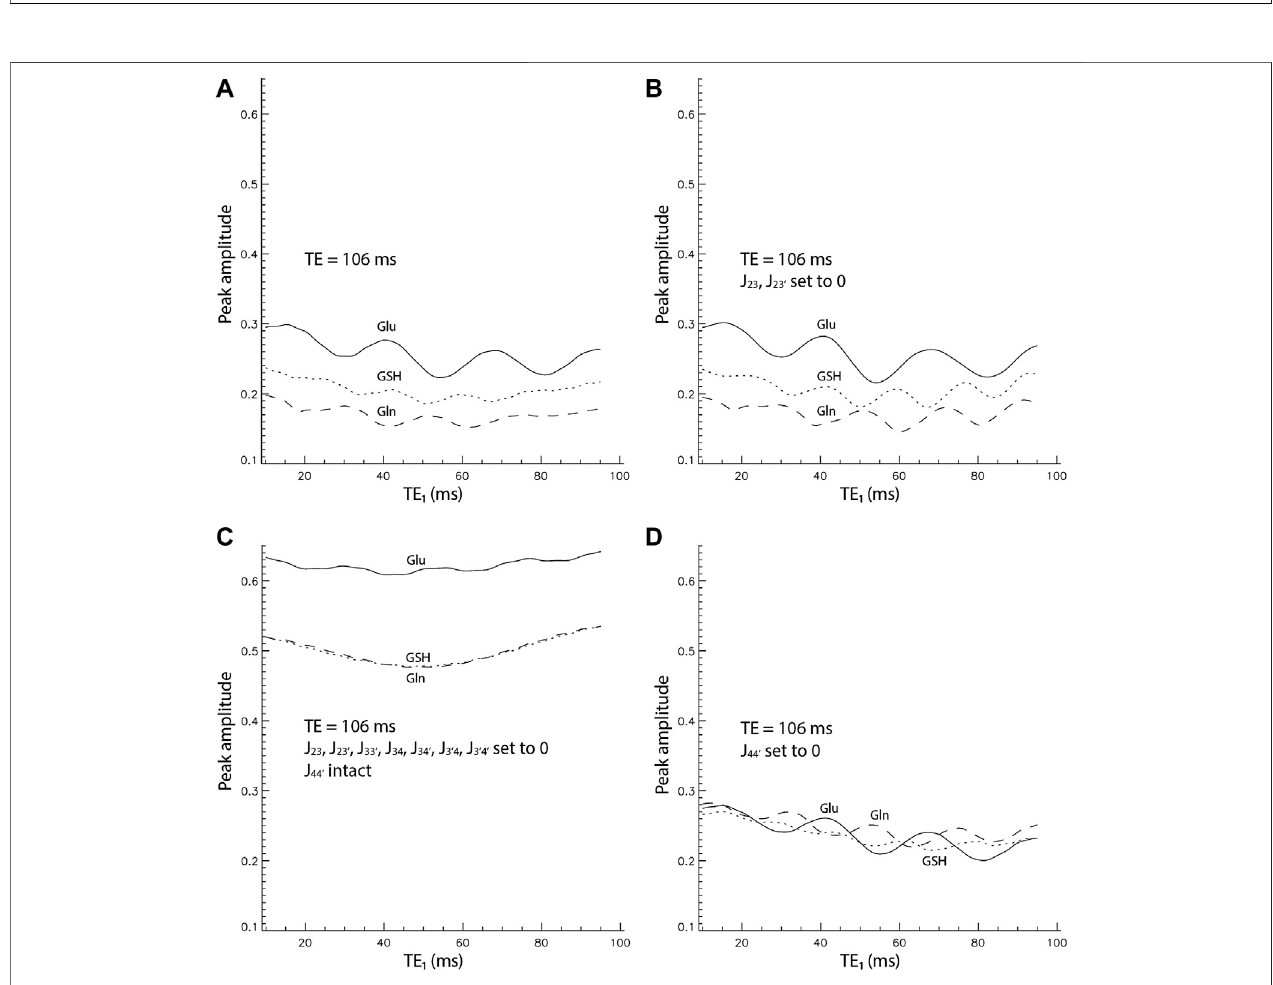
FIGURE3| Peakamplitudevs.TE 1 curvesbyfulldensity matrixsimulationsforTE=106 ms.Thepeakamplitudeswerenormalized relativetotheNAAsinglet. (A) . All coupling constants were intact. (B) . J 23 and J 23 ’ were set to 0. (C) . All coupling constants were set to 0 except J 44 ’ . (D) . Only J 44 ’ was set to 0.